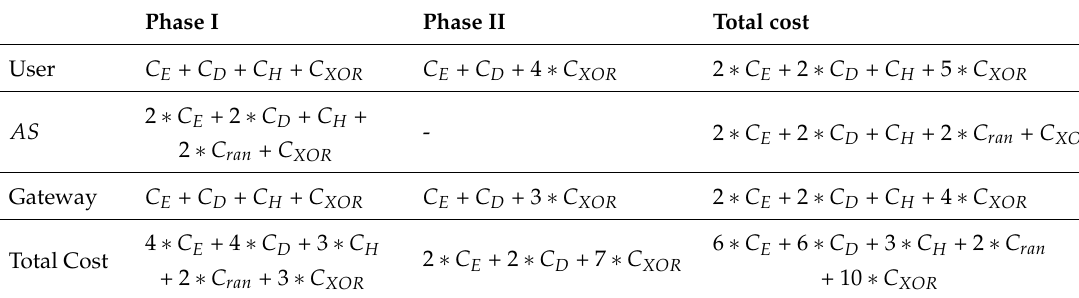
Table 4. Computational cost of proposed protocol.